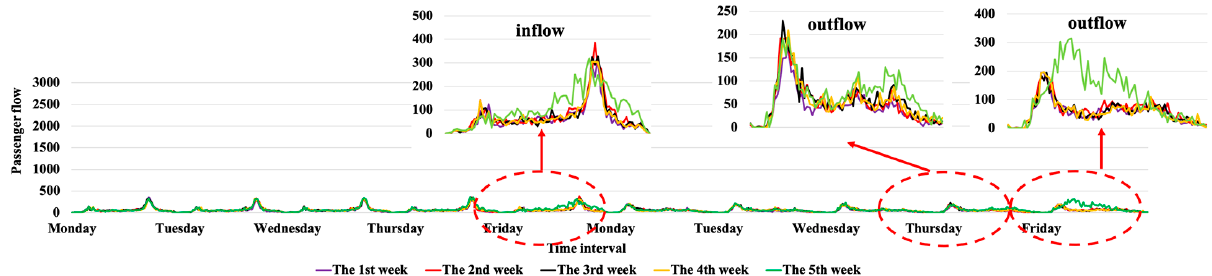
Figure 7. Inflow and outflow at 1st Wharf Station in the Xiamen BRT on Tomb Sweeping Day.